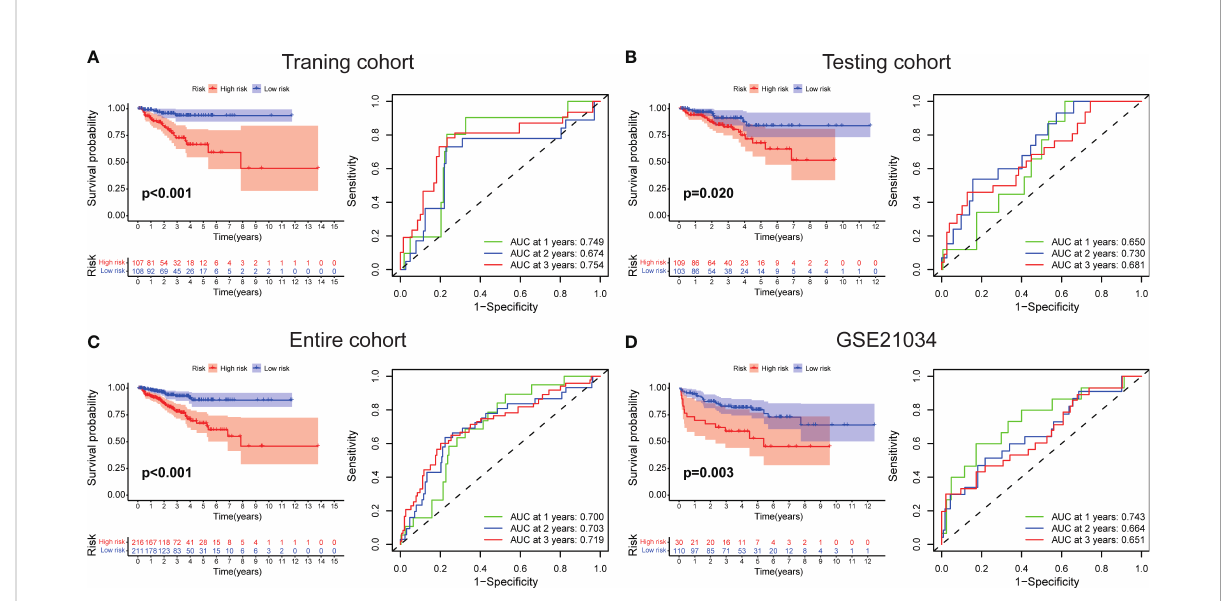
FIGURE 3 Evaluation of the signature. The BCR-free survival and ROC curves in (A) the training TCGA-PRAD, (B) the testing TCGA-PRAD, (C) entire TCGA- PRAD, and (D) GSE21034 cohorts.